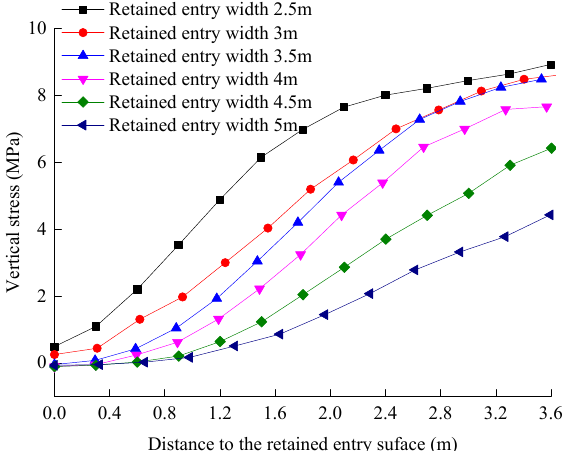
Figure 12. Vertical stress of the immediate roof at the middle of the retained entry.